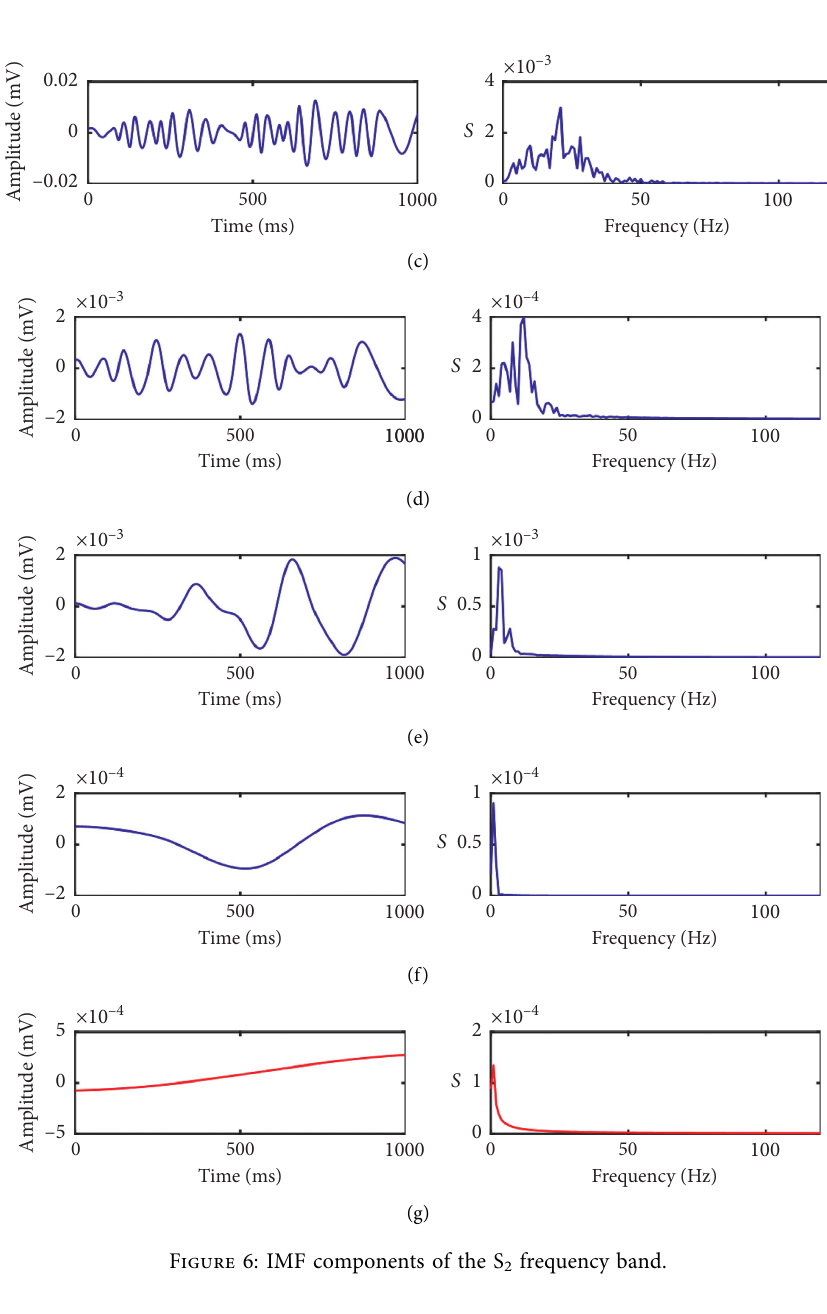
2 frequency band.